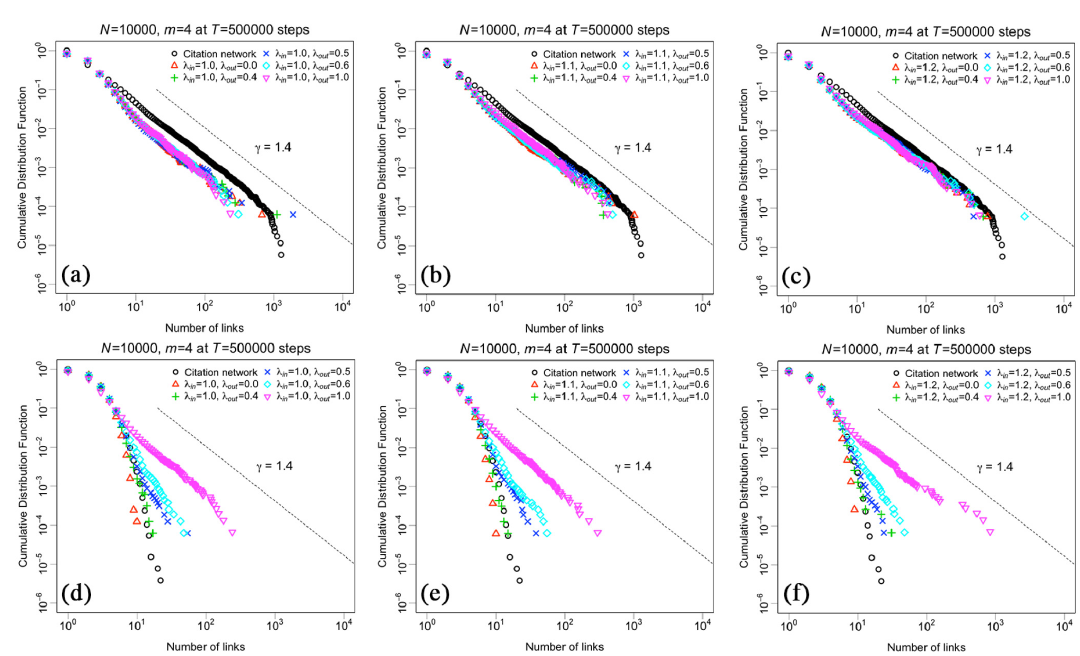
Fig 6. Cumulative degree distributions generated by the simulation results in a log-log scale plot by N = 10, 000, T = 500, 000, and m = 4. Each panel (a), (b) and (c) shows the in-degree distribution by λ in = 1.0, λ in = 1.1 and λ in = 1.2, respectively, and each panel (d), (e) and (f) shows the out-degree distribution by λ = 1.0, λ = 1.1 and λ = 1.2, respectively. Each black circle, red triangle, green in in in plus-mark, blue cross, light-blue rhombus, and pink descending triangle show the result by the citation network in 2018, λ out = 0.0, λ out = 0.4, λ out = 0.5, λ out = 0.6, and λ out = 1.0, respectively. Each dotted line indicates the power law distribution with the exponent γ = 1.4.